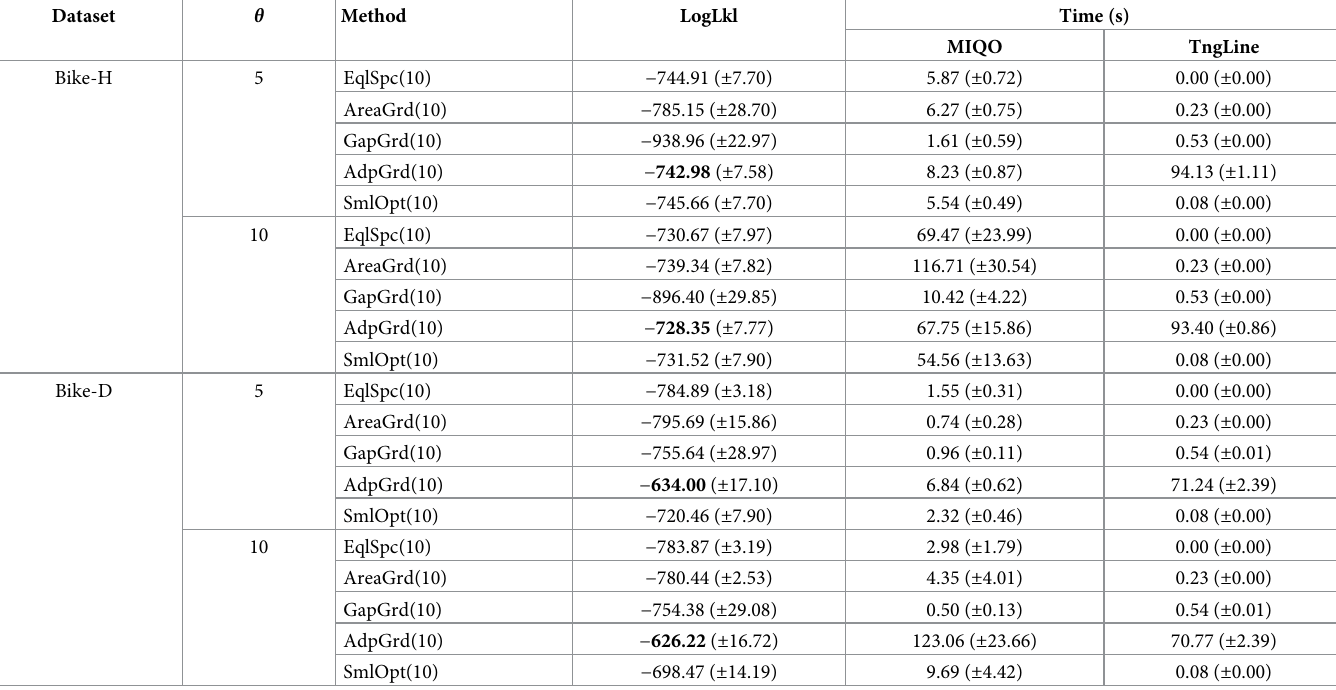
Table 6. Results of our MIQO formulation for real-world training instances. Dataset